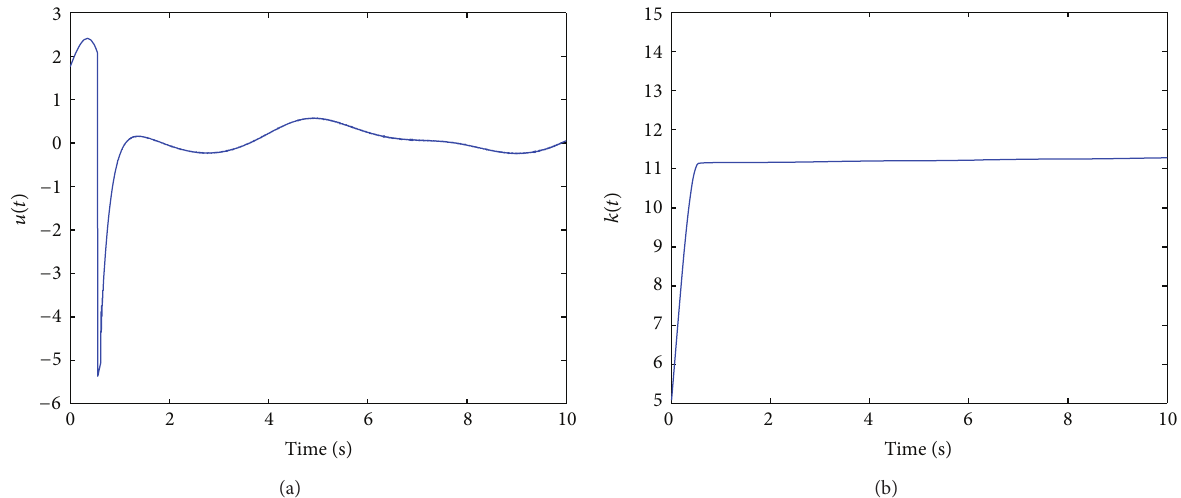
Figure 2: (a) Control input with TPASMC. (b) Adaptive gain